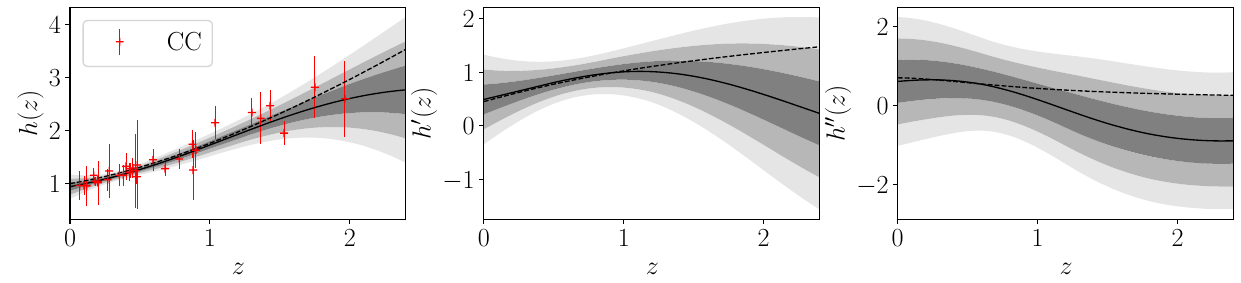
Fig. 3 Plots for the reconstructed dimensionless Hubble parameter h ( z ) , it’s derivatives h (cid:3) ( z ) and h (cid:3)(cid:3) ( z ) using CC data. The black solid line is the best fit curve and the associated 1 σ , 2 σ and 3 σ confidence regions are shown in lighter shades. The specific points (in the left figure) with error bars represent the observational data. The black dashed line is for the (cid:2) CDM model with (cid:12) m 0 = 0 . 3